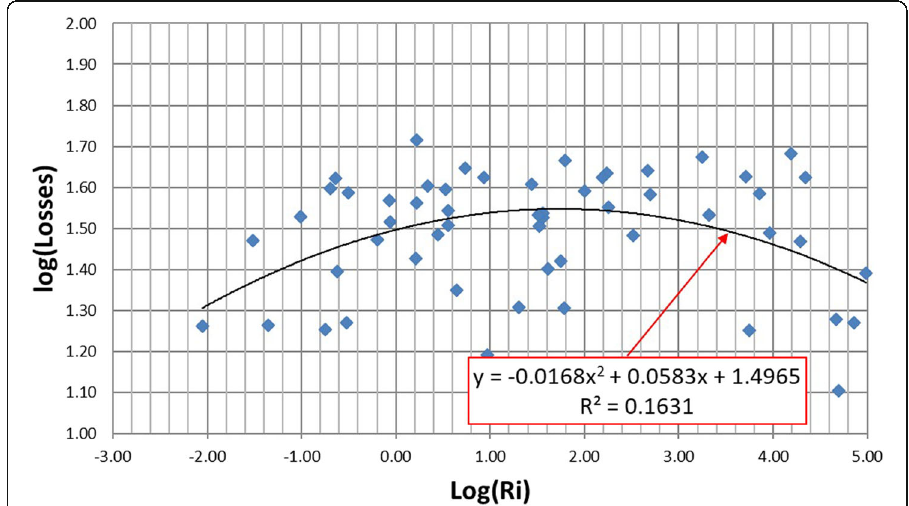
Fig. 14 Log Losses vs Log R